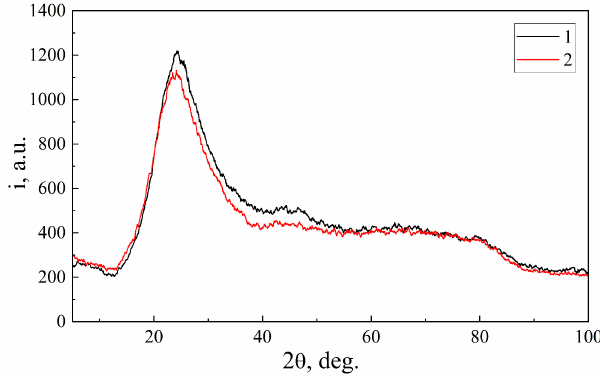
Figure 2. XRD diffraction patterns of: (1) MSM-41 matrices, and (2) MSM-41<SFA encapsulate.